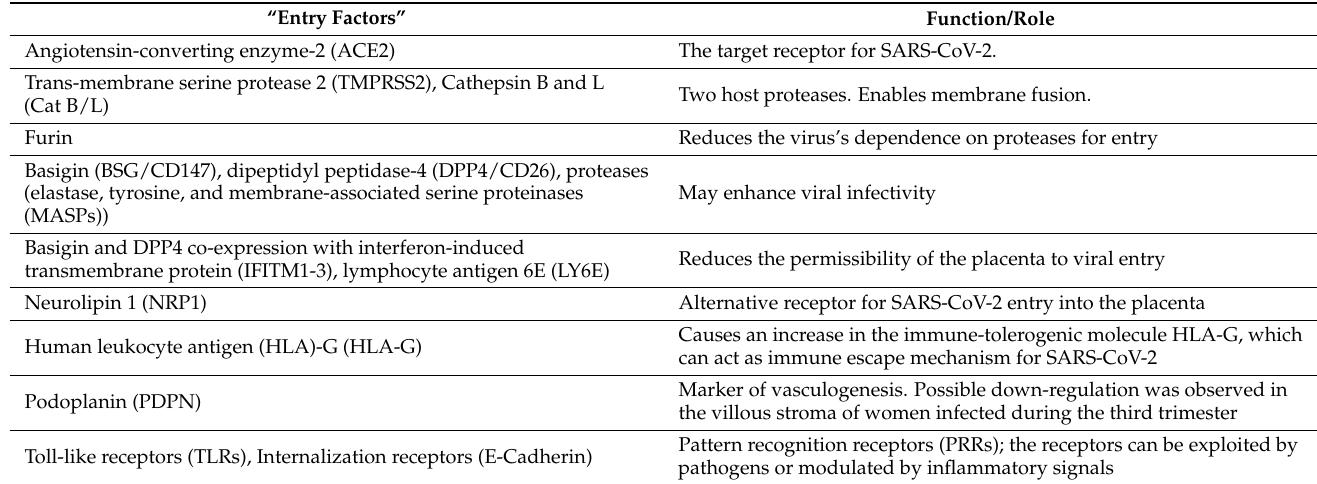
Table 1. Entry factors, other factors, and immunoplacental barriers for SARS-CoV-2 [10,25–40]. “Entry Factors” Function/Role The target receptor for